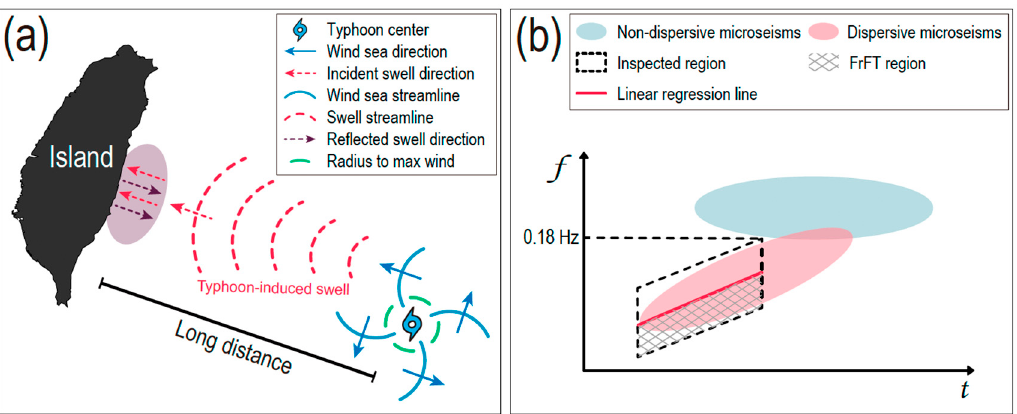
Figure 3. Schematic of ( a ) DF microseism generation by typhoon-induced swells, and ( b ) dispersive DF microseisms as they would appear on a spectrogram. When the typhoon-induced swells propagate through deep water over long distances, high-frequency components travel more slowly than low-frequency components, and consequently, the observed DF microseisms are frequency-dispersed, with an energy distribution (pink ellipse) tilting from lower-left to upper-right. For interpretation, see the text.